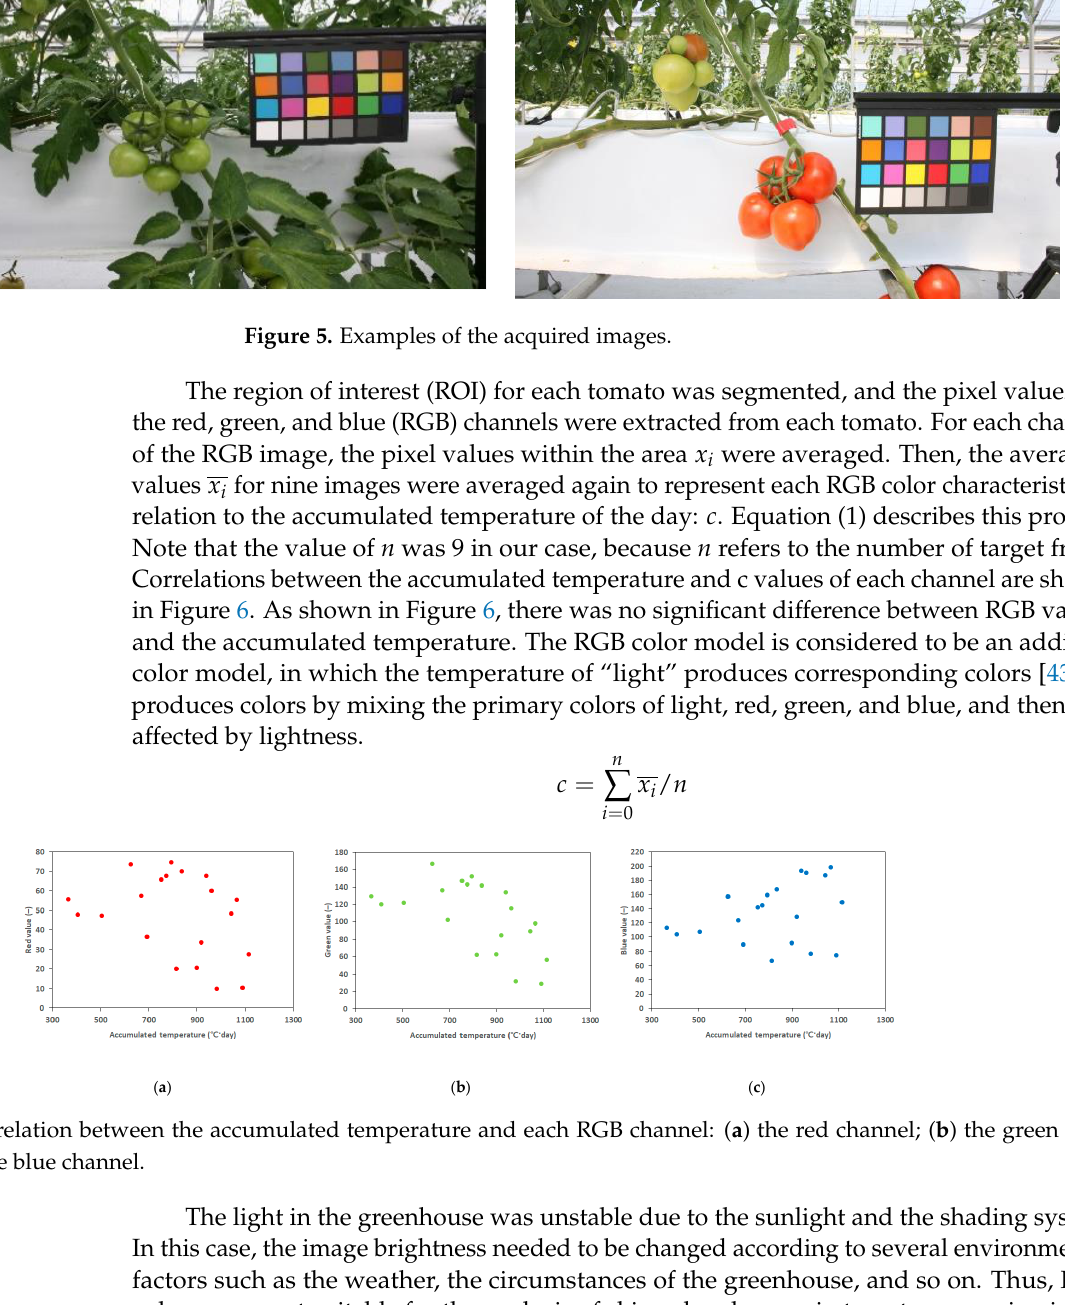
Figure 6. Correlation between the accumulated temperature and each RGB channel: ( a ) the red channel; ( b ) the green channel; ( c ) the blue channel.